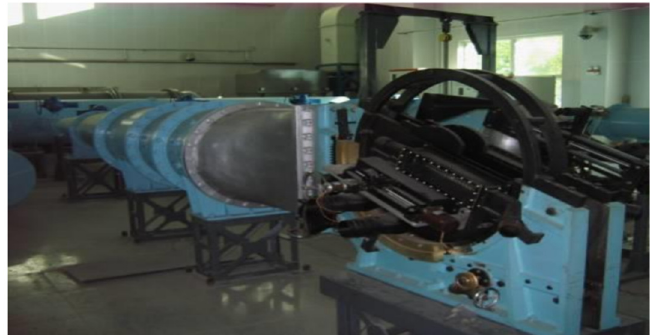
Figure 9. Physical image of test system. Figure 7. Physical image of test